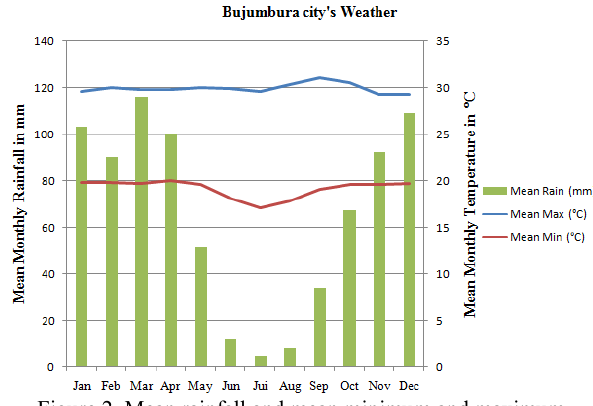
Figure 2. Mean rainfall and mean minimum and maximum temperatures in Bujumbura during 1984-2013